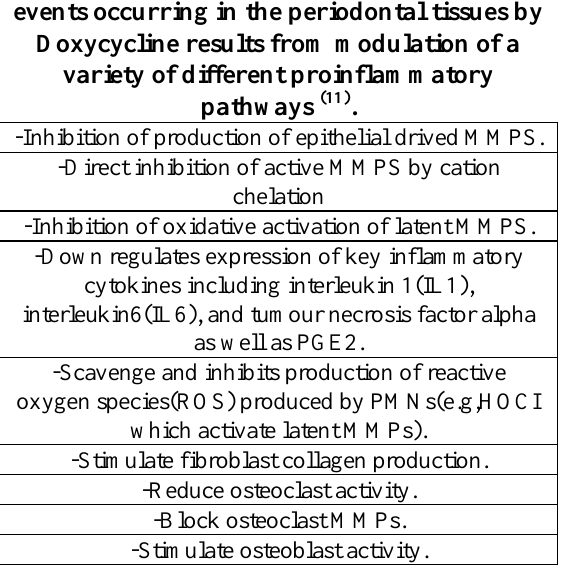
Table1: The mechanisms by which Doxycycline inhibits connective